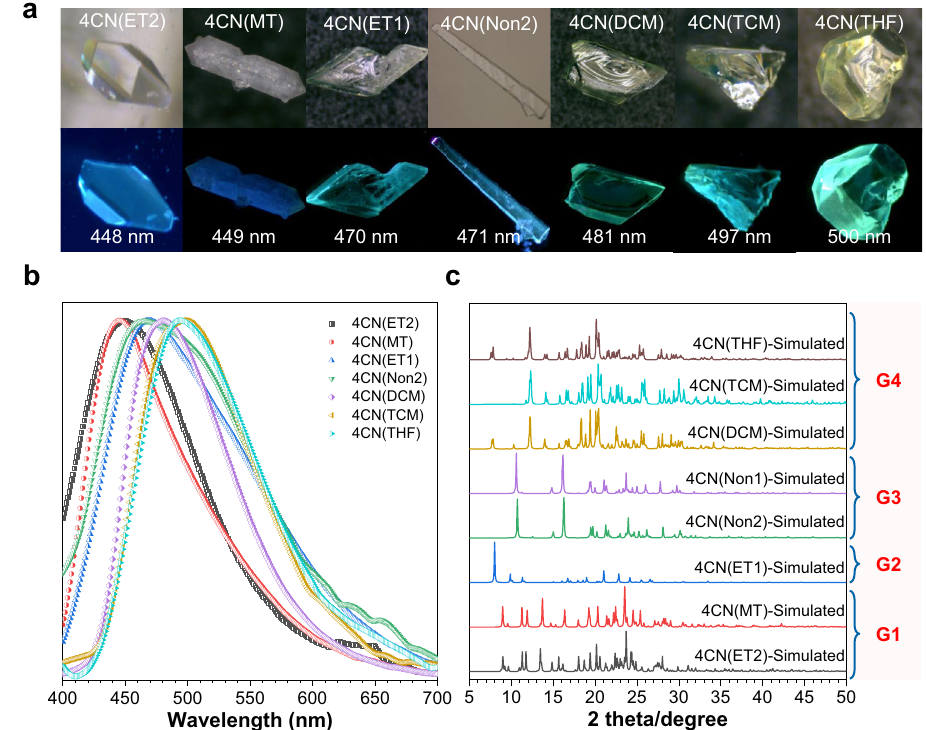
Fig. 3 Multiple emissive crystals of 4CN. a The photographs of different crystals of 4CN under daylight ( fi rst row) and UV light (second row). b Normalized fl uorescent emission spectra of different crystals. c The corresponding simulated PXRD patterns of different crystals, that is, 4CN(ET2) and 4CN(MT) in group 1 ( G1 ), 4CN(ET1) in group 2 ( G2 ), 4CN(Non1) and 4CN(Non2) in group 3 ( G3 ) or 4CN(THF), 4CN(DCM) and 4CN(TCM) in group 4 ( G4